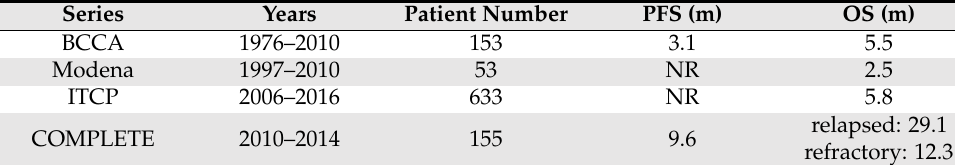
Table 1. Historic Outcomes in relapsed/refractory T-cell